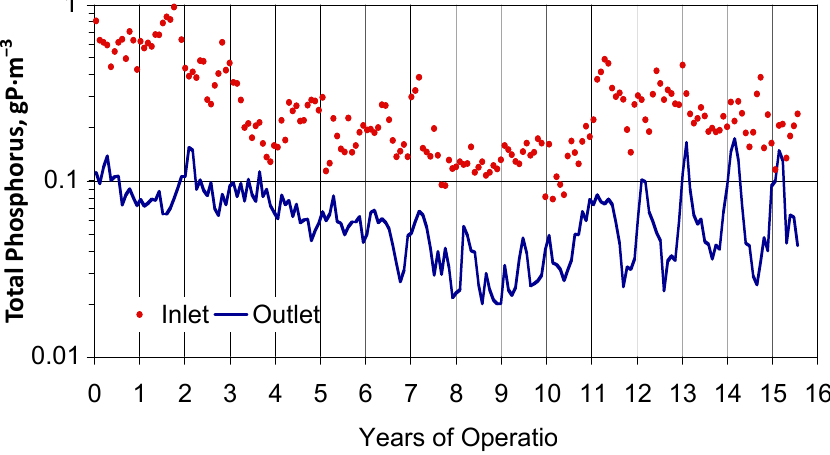
Figure 18. Time progression of inlet and outlet TP concentrations for the OEW system. Table 6. Time trends in annual concentration reduction (CR), rate coefficients (k), and P load removed (PLR) for large P wetlands. Two natural wetlands are included because of their long history. Slopes are in percent per